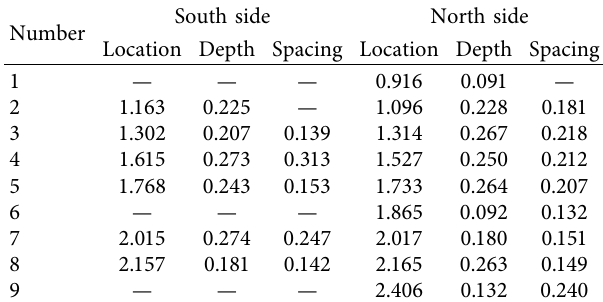
Table 2: Measured data of the cracking pattern for the beam B1 at the 2nd test stage (unit: m).